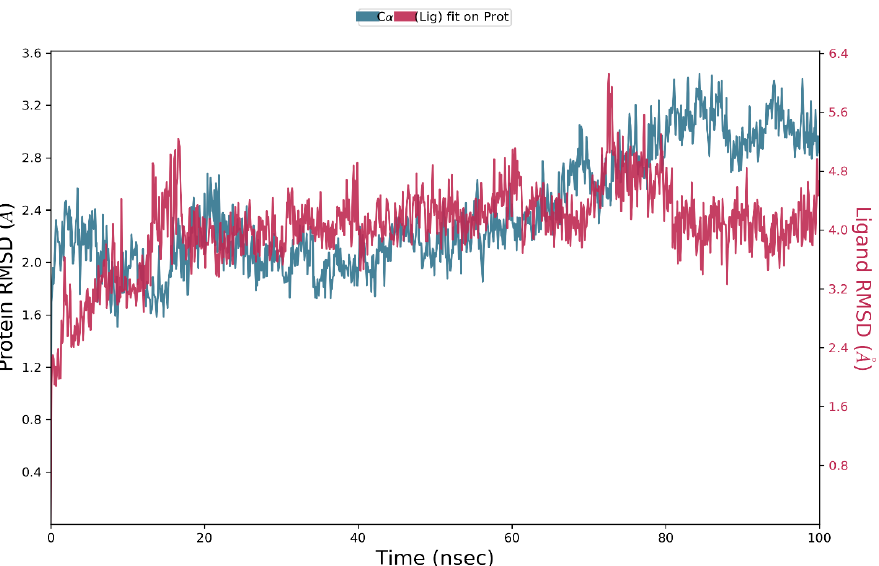
Figure 3. RMSD of protein and ligand throughout the 100 ns simulation; the interactions of PvdA and N-2-succinyl-ornithine were found to be stable after 40 ns. The Ligand Root Mean Square Fluctuation (L-RMSF) is useful for characterizing changes in the ligand atom positions. The average change in the position of all the 13 atoms of the ligand is shown in the plot (Figures 4, S2 and S6). This indicates all the atoms underwent minimal or no changes during the 100 ns dynamic simulation. This confirms the stability of the ligand binding to the protein.